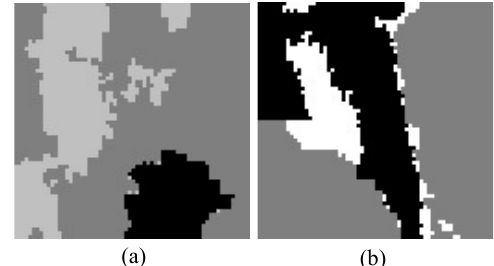
Figure 2. Segmentation results: (a) coastal image segmentation, and (b) city image